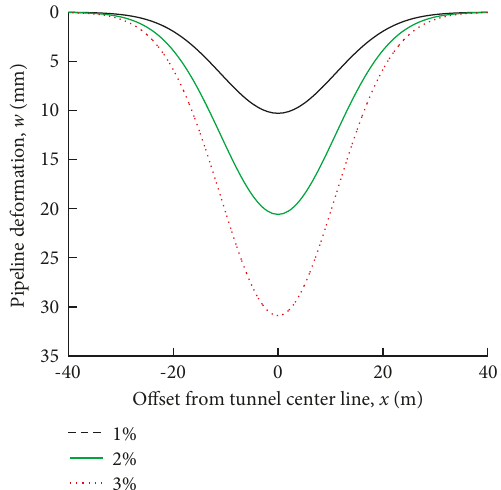
Figure 9: Pipeline deformation under different formation loss